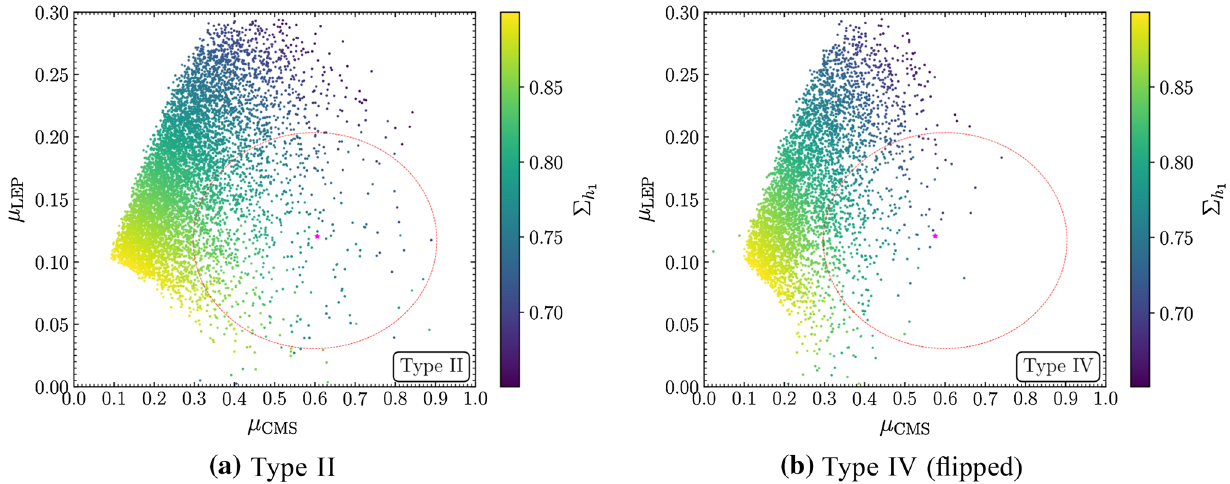
Fig. 10 Shownarethesignalstrengths μ CMS and μ LEP foreachparam- eter point respecting the experimental and theoretical constrains in the type II and the type IV scenario. The 1 σ -region of both excesses is